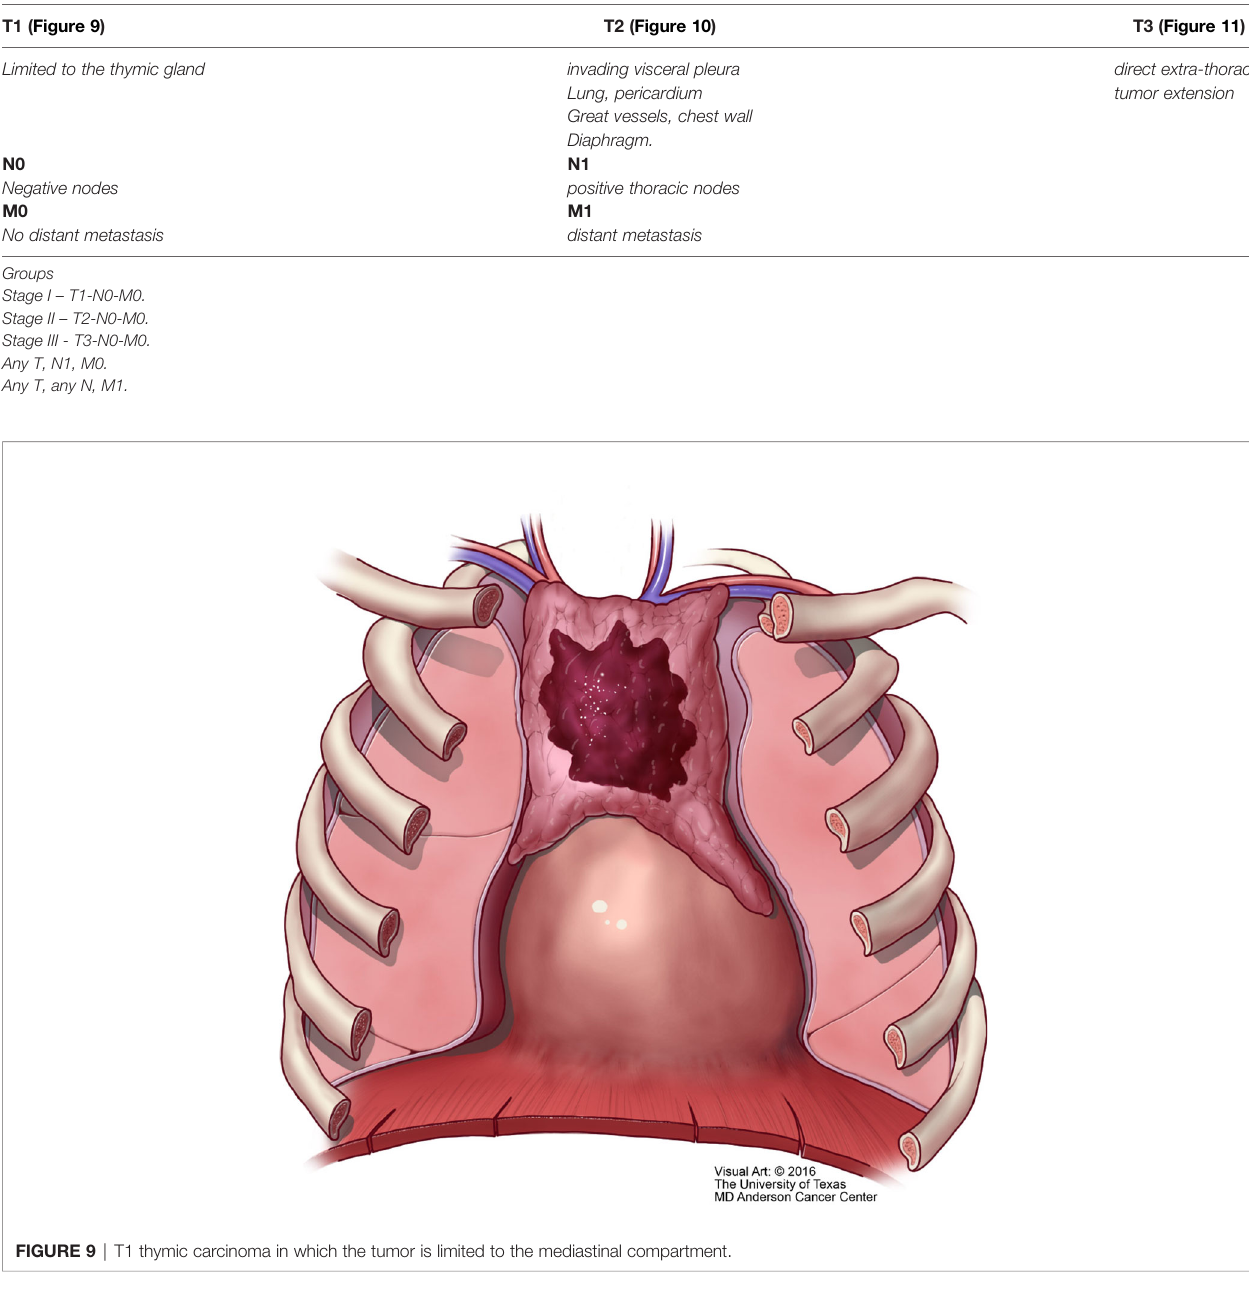
TABLE 1 | Suggested TNM staging system for thymic